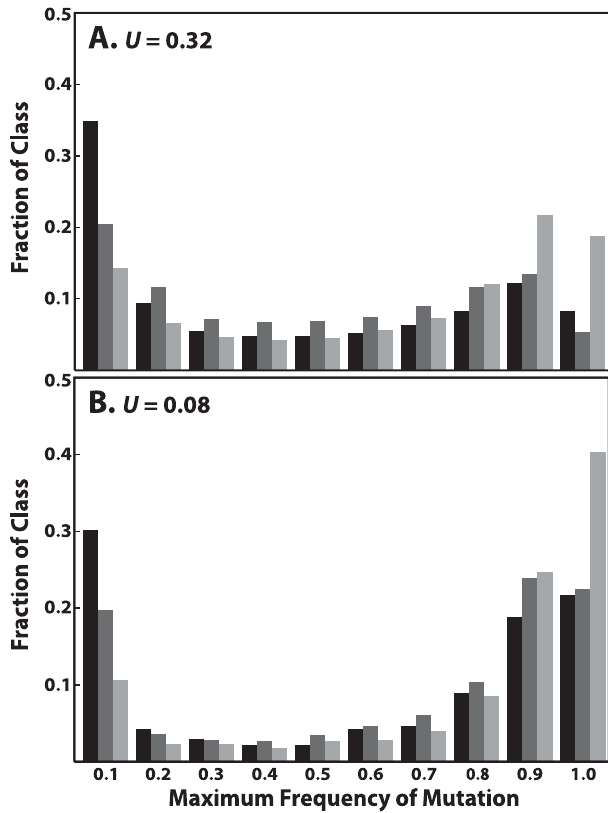
Figure 3. The Maximum Frequency of Ancestral Mutations (Those Forming the Dominant Mutational Lineage from the Founding Population to the MRCA of the Ending Population) That Did Not Fix The black, dark gray, and light gray bars correspond to mutations with initial fitness effects that are deleterious, neutral, and beneficial, respectively. The x -axis is the upper bin bound for the frequency attained (e.g., 0.20 includes those mutations whose maximum frequency is greater than 0.10 and less than or equal to 0.20). The y -axis is the fraction of mutations in each class that attained each frequency range. The top pane (A) shows the frequency distribution for U ¼ 0.32, and the bottom pane (B) depicts U ¼ 0.08. DOI: 10.1371/journal.pcbi.0020141.g003